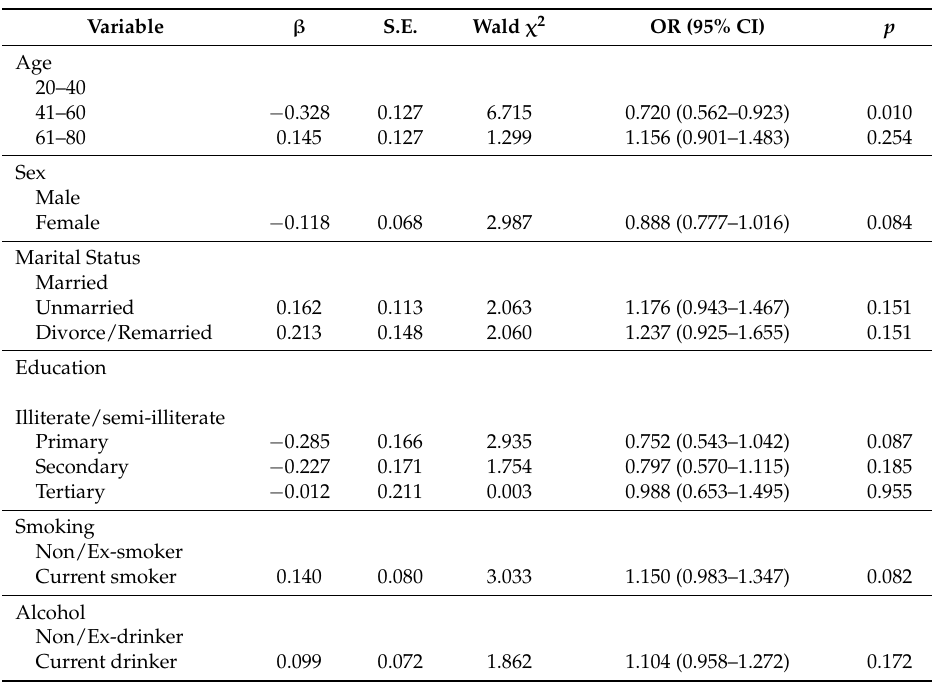
Table 3. Factors associated with pre-diabetes in univariate logistic regression